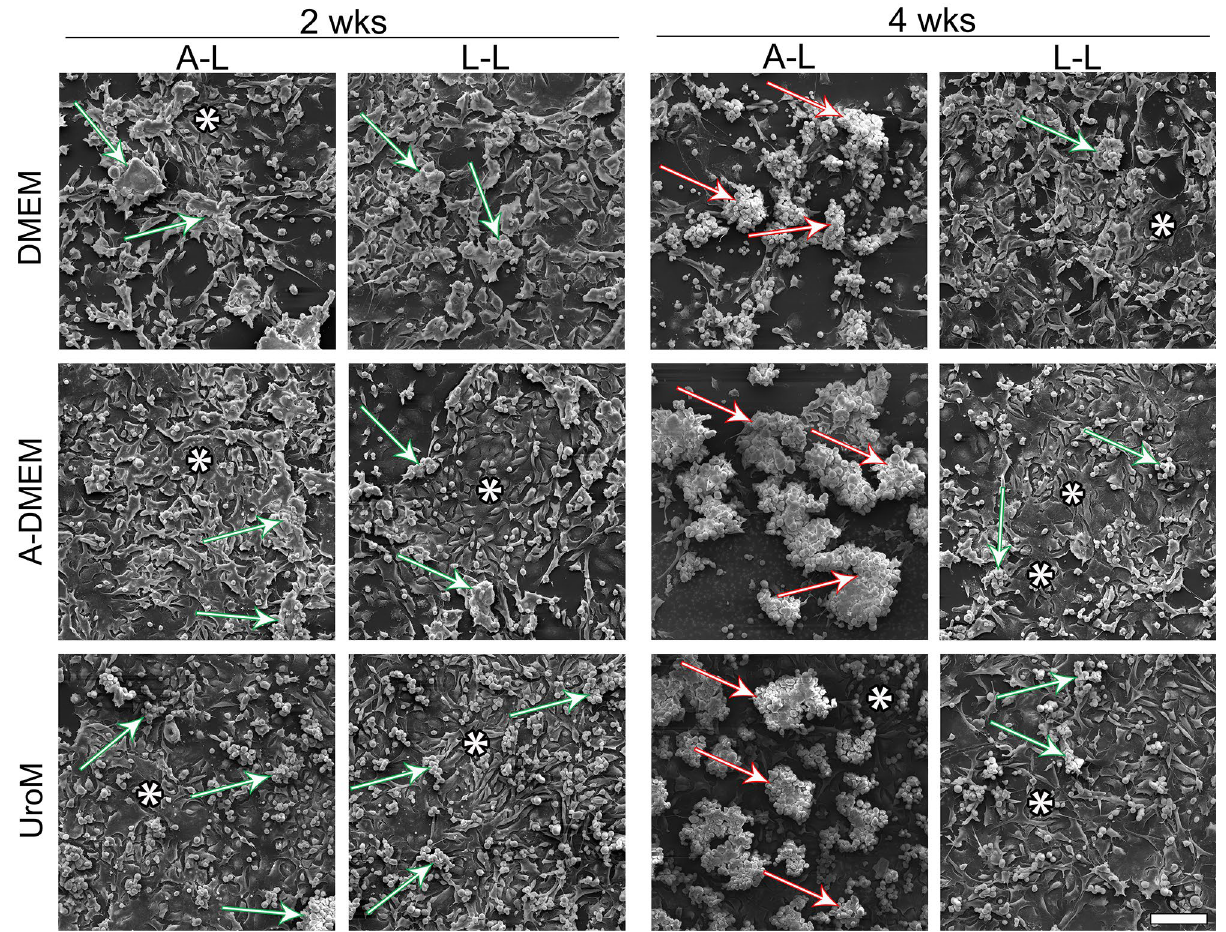
Figure 3. Apical surface structure of FLO-1 cells forming clusters and spheres at the A–L and L–L interfaces, respectively, surrounded by polygonal cells. FLO-1 cells were cultured on porous membranes and maintained in DMEM, A-DMEM or UroM media at the A–L and L–L interfaces for 2 or 4 wks and analyzed with low magnification SEM. Cells exhibit a polygonal morphology (asterisks) or a round morphology and form small clusters (green arrows) or large spheres (red arrows). Scale bar, 100 (Fig. 3, Supplemental Fig. S2). After 4 wks, the diameter of the spheres reached up to 150–200 µm (Fig. 3). The spheres had a round or oval grape-like appearance, consisting of round cells with a smooth or rough surface (Fig. 4, Supplemental Fig. S3). Between the spheres, polygonal cells with tighter cell connections were present (Figs. 3, 4, Supplemental Fig. S3). Small cell clusters of round/oval cells (diameter 50 µm) were found at the L–L interface while large spheres, as observed at the A–L interface, were not formed (Fig. 3, Supplemental Fig. S3). However, similarly as spheres at the A–L interface, the cell clusters were surrounded by areas of cells with a